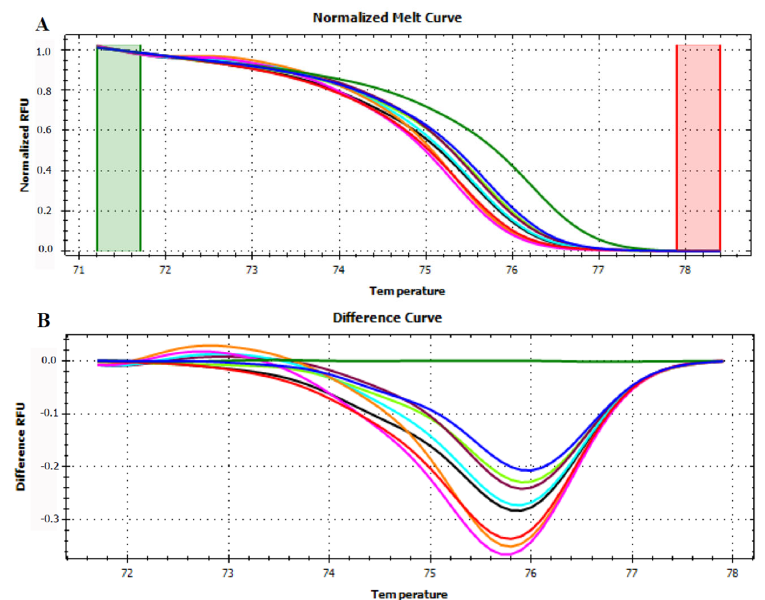
Figure 5. Normalized melt curves ( A ) and difference curves ( B ) of HRMA of P6 loop of trnL (UAA) intron on apple and peach mixed juices. Apple fruit: red, peach fruit: blue, apple/peach juices 99.5%/0.5%: pink, 99%/1%: orange, 95%/5%: light blue, 90%/10%: violet, 75%/25%: light green and 50%/50%: black. Reference cluster kiwi fruit: green. The HRMA has been carried out on three independent replicates of each sample and the most representative curve of each sample is reported in the graph.